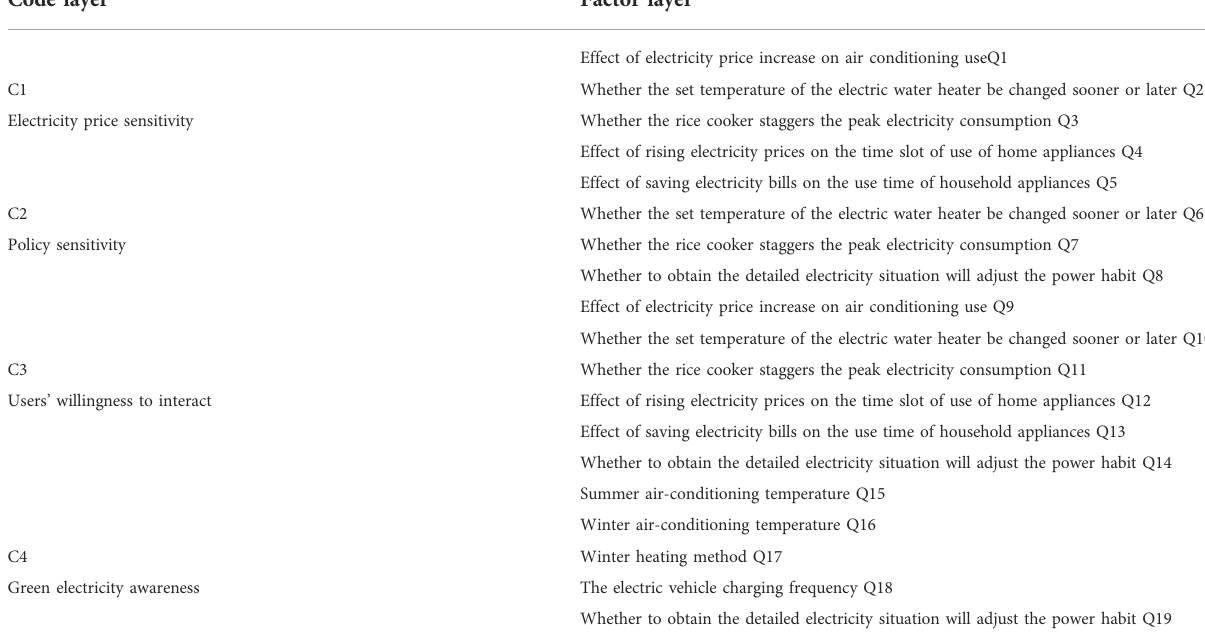
TABLE 1 The hierarchical system for